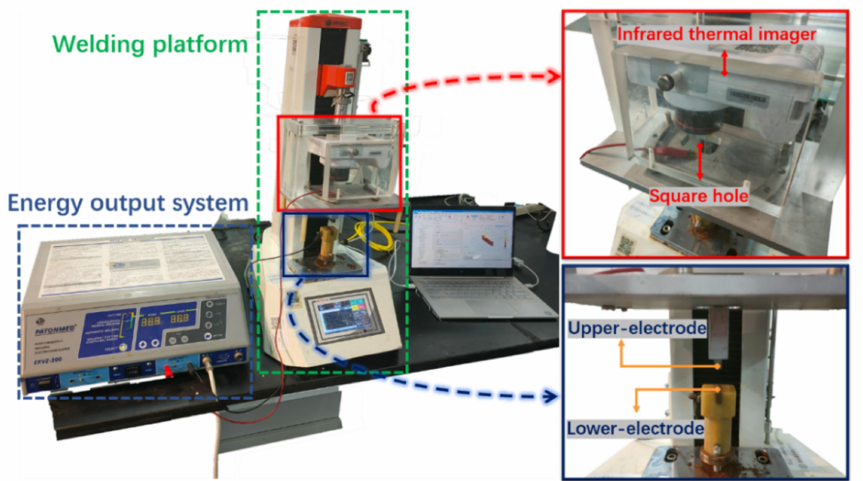
Figure 1. Physical map of H.F.E.W. experimental setup. In the experiment, the rigid structure composed of a tensimeter base, infrared thermal imager and upper-electrode compresses the tissue downward, the infrared thermal imager can record the temperature distribution in the welding process through the square hole, and the electrical parameters are measured and displayed by an oscilloscope (including current ring and voltage probe) (not